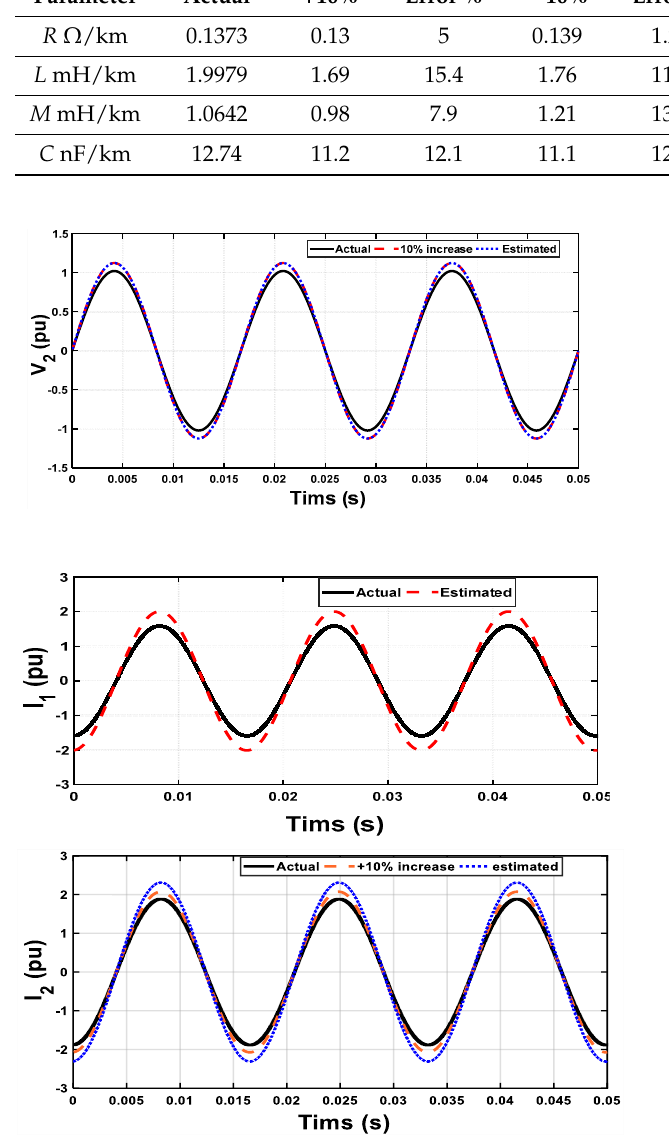
Figure 6. Voltages and currents waveforms at both ends of the TL with 10% error in V 2 and I 2 measurements along with a 20% synchronization error from case study-2.